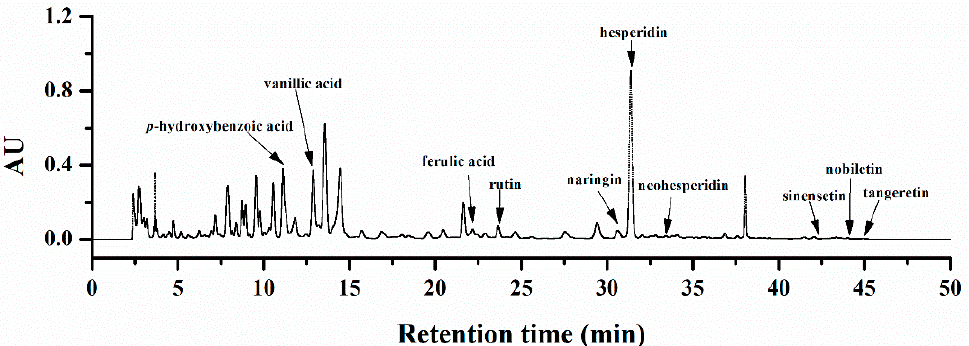
Figure 1. HPLC chromatogram of phytochemicals of orange extracts at 283 nm.